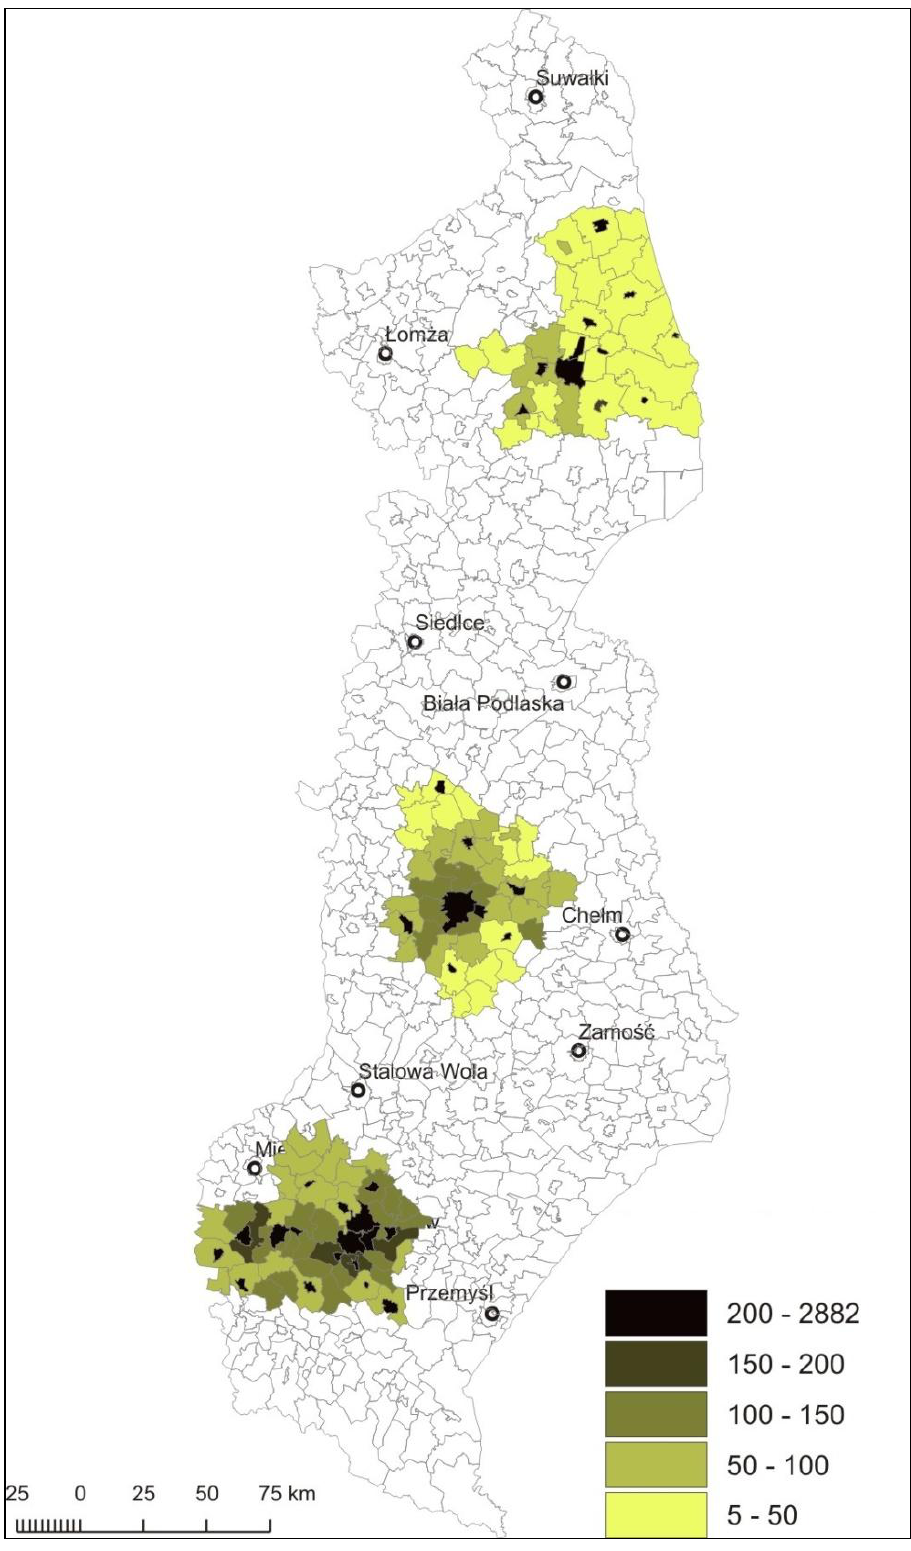
Fig. 1. Population density in the Białystok, Lublin and Rzeszów Metropolitan Areas